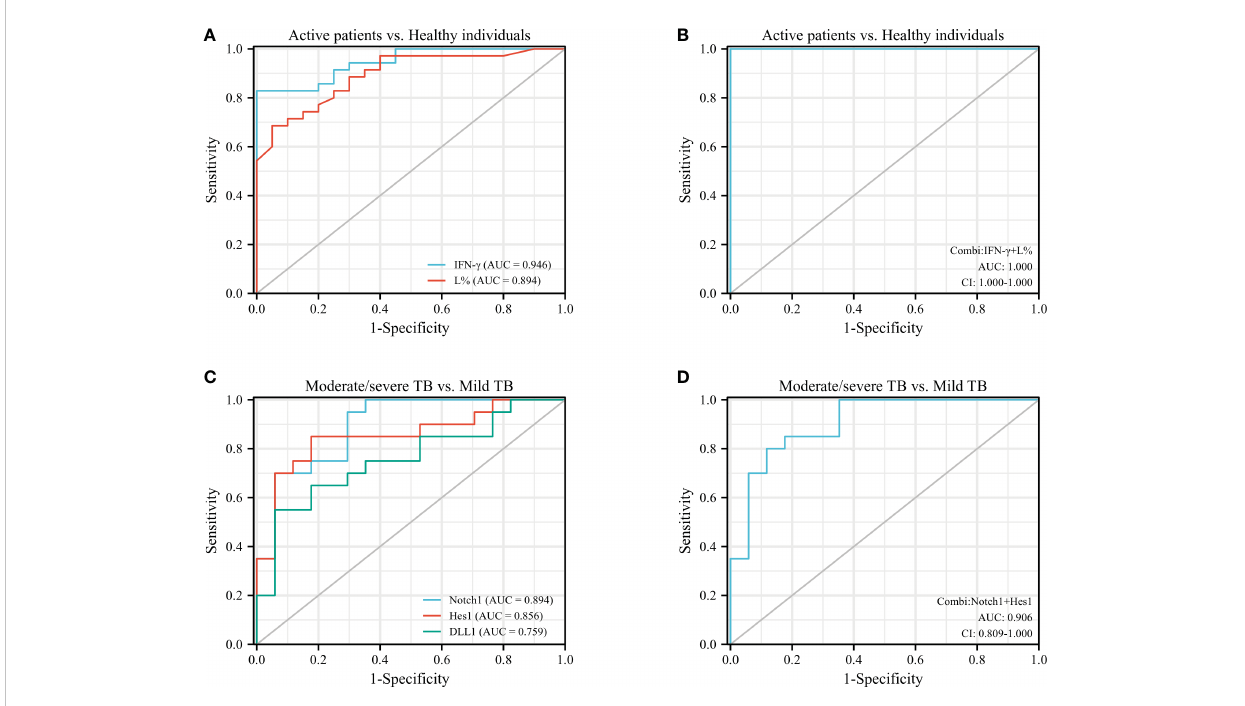
FIGURE 5 ROC analysis was performed to assess the diagnostic value of IFN- g , L%, Notch1, DLL1, and Hes1 in patients with different stages of active TB. (A) , ROC analysis of IFN- g and L% in active TB cases vs. healthy individuals; (B) , combiROC of IFN- g and L% in active TB patients vs. healthy controls; (C) , ROC analysis of Notch1, DLL1 and Hes1 in moderate/severe TB patients vs. mild TB patients; (D) , combiROC analysis of Notch1 and Hes1 in moderate/severe TB cases vs. mild TB